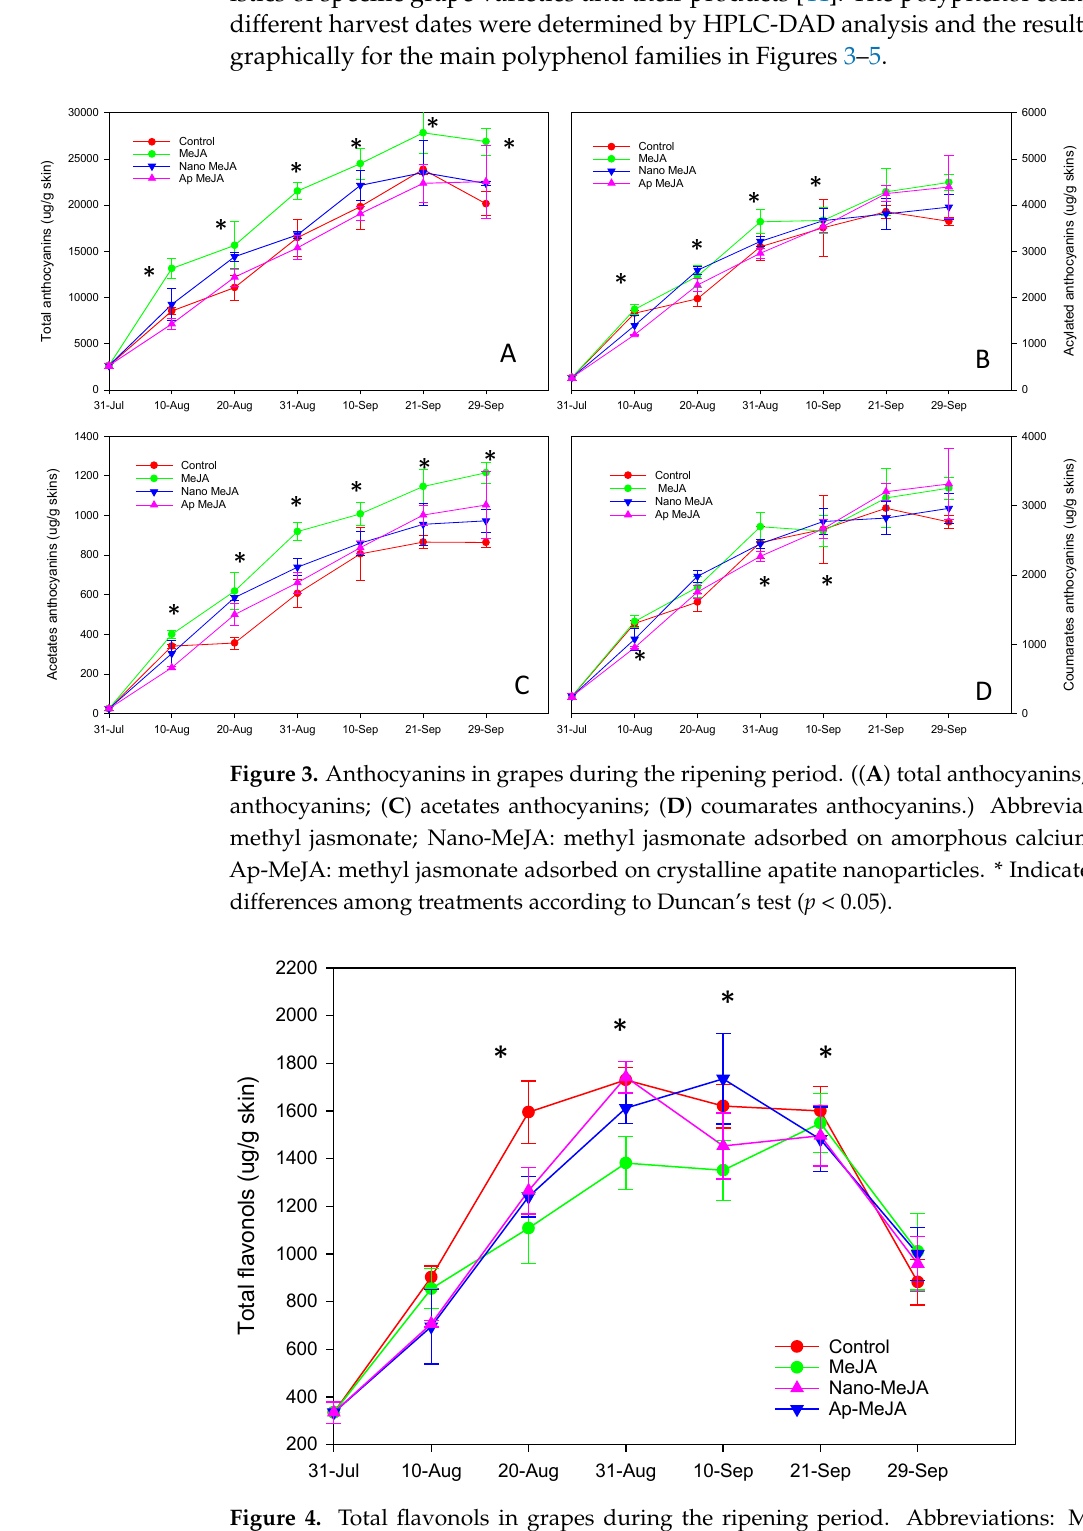
Figure 4. Total flavonols in grapes during the ripening period. Abbreviations: MeJA: methyl jasmonate; Nano-MeJA: methyl jasmonate adsorbed on amorphous calcium phosphate; Ap-MeJA: methyl jasmonate supported on crsiallimum calcium phosphate. * Indicates significant differences among treatments according to Duncan’s test ( p <